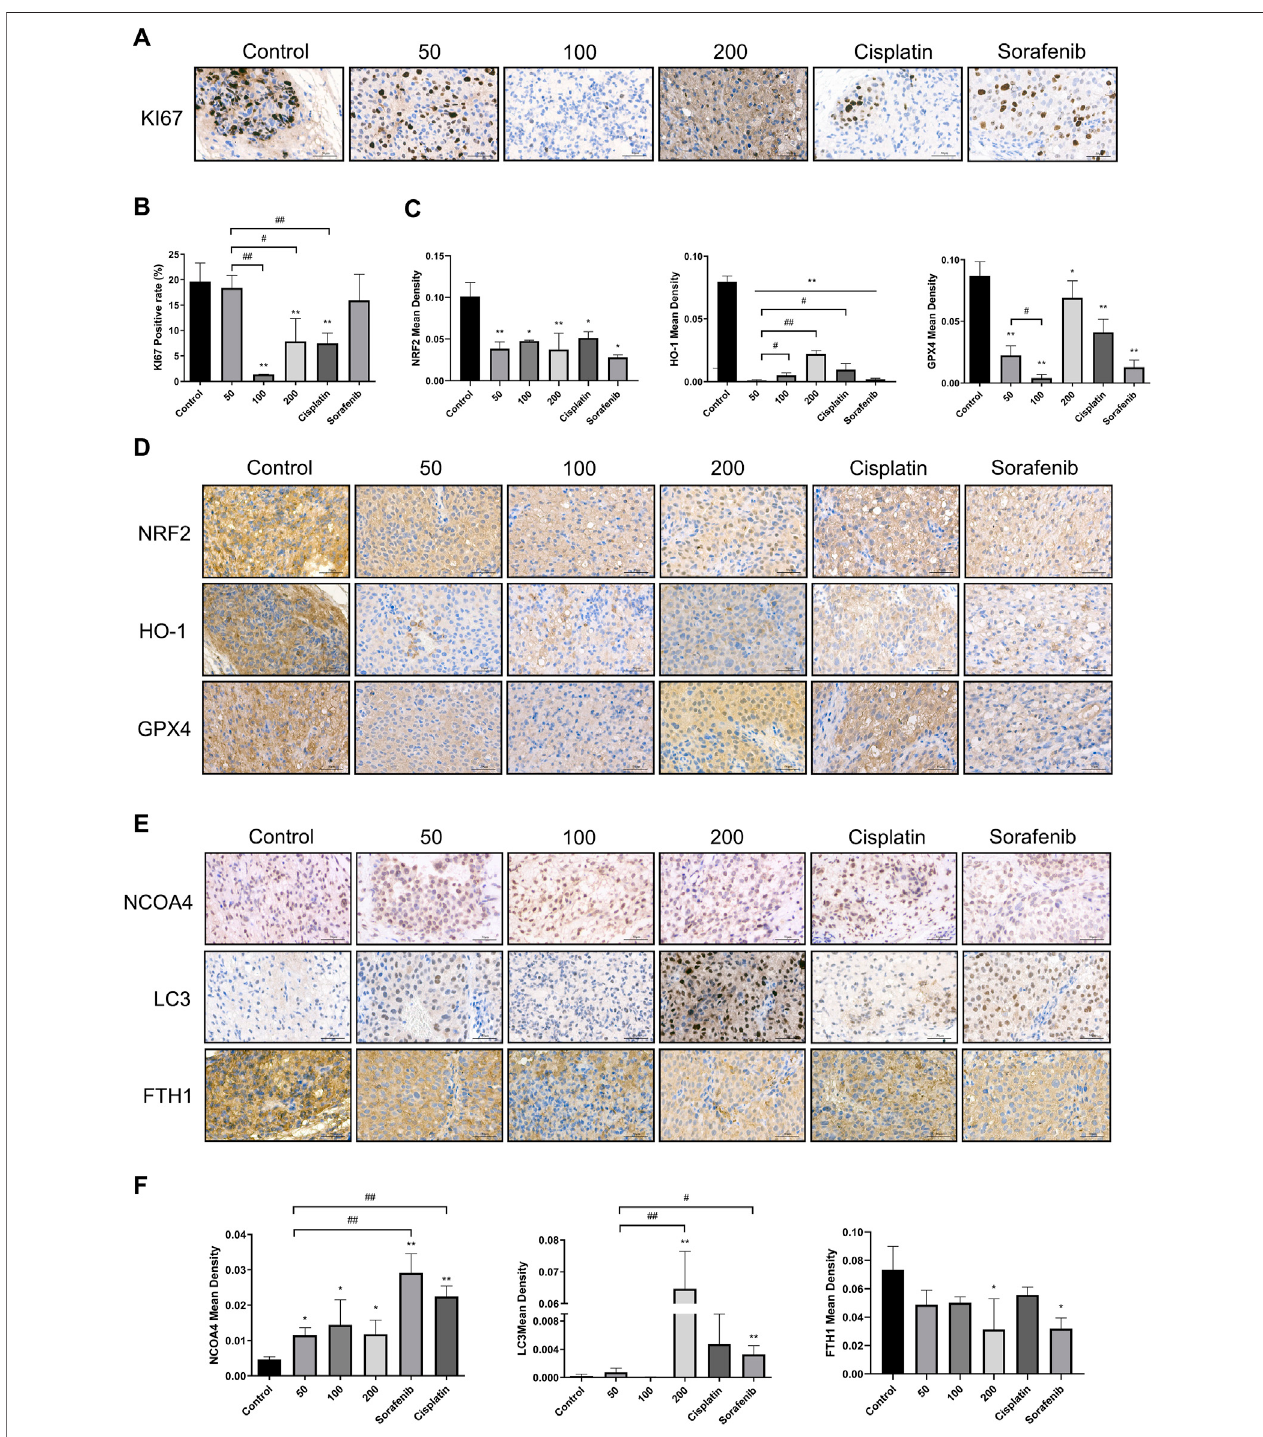
FIGURE 8 | Effects of caryophyllene oxide on protein expression in hepatocellular carcinoma in vivo . (A) , (B) Immunohistochemistry was used to identify the expressionofKI67bycaryophylleneoxide; (C) , (D) todetecttheexpressionofNRF2,HO-1,andGPX4protein,and (E) , (F) todetecttheexpressionofNCOA4,LC3,and FTH1. The ruler measures 50 μ m. The data were from three different tests ( n = 3). The data were presented as mean ± SD. * p < 0.05, ** p < 0.01 when compared to the control group. # p < 0.05, ## p < 0.01 when compared to the 50 mg/kg group.